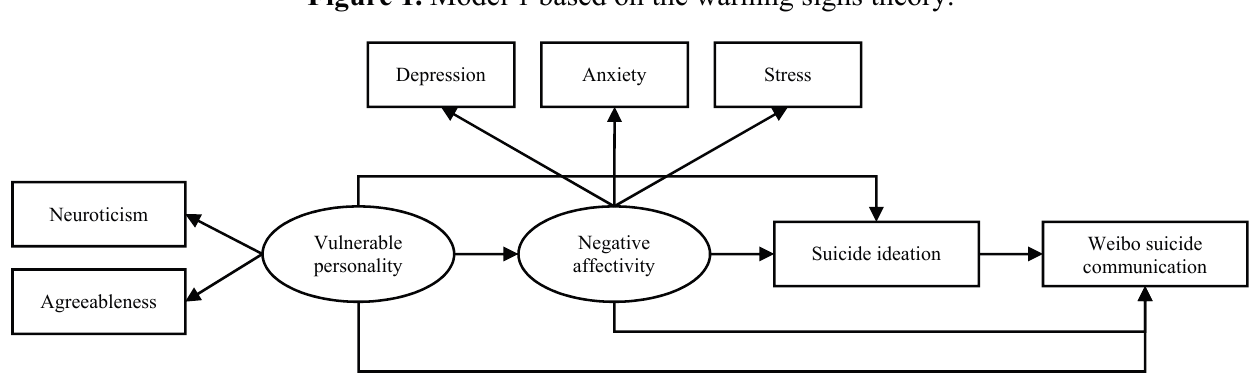
Figure 1. Model 1 based on the warning signs theory.